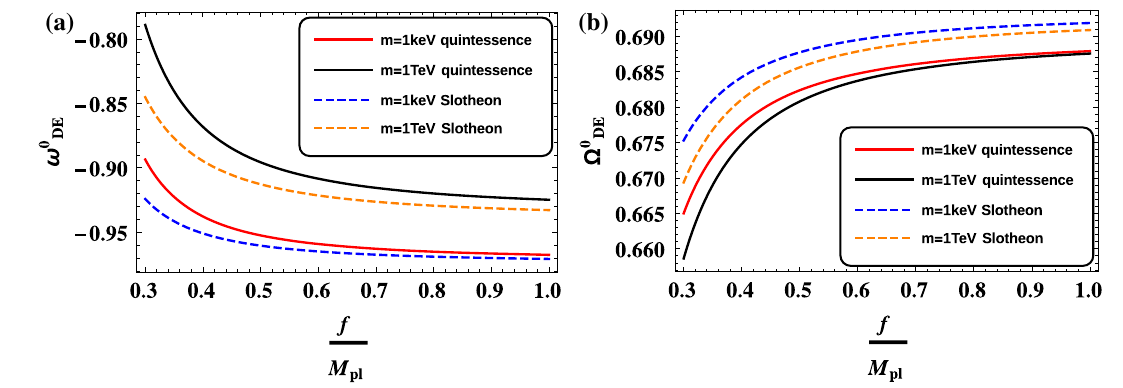
Fig. 6 a (Left panel) Comparisons of evolutions of the present epoch value of dark energy equation of state parameter with f quintessence dark energy model (solid lines) and Slotheon field dark energy model (dashed lines) for two chosen dark matter “bare” masses